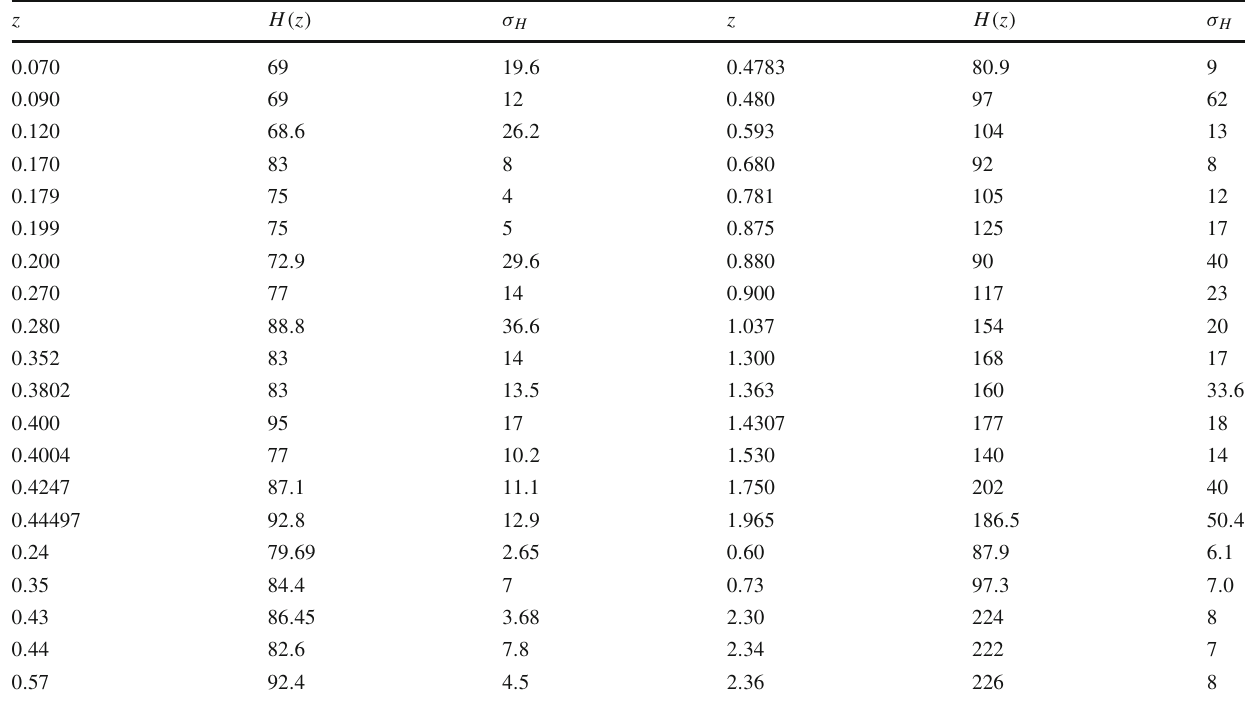
upper panel corresponds to 30 samples deduced from the differential age method. The lower panel, to 10 samples obtained from the radial